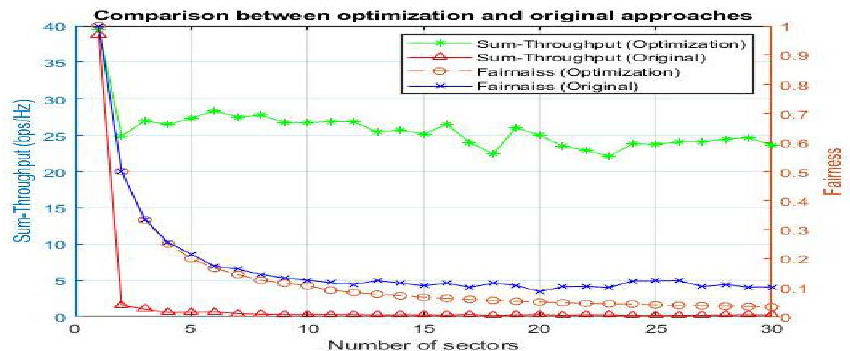
Figure 10. Trade-off: comparison between optimization and original